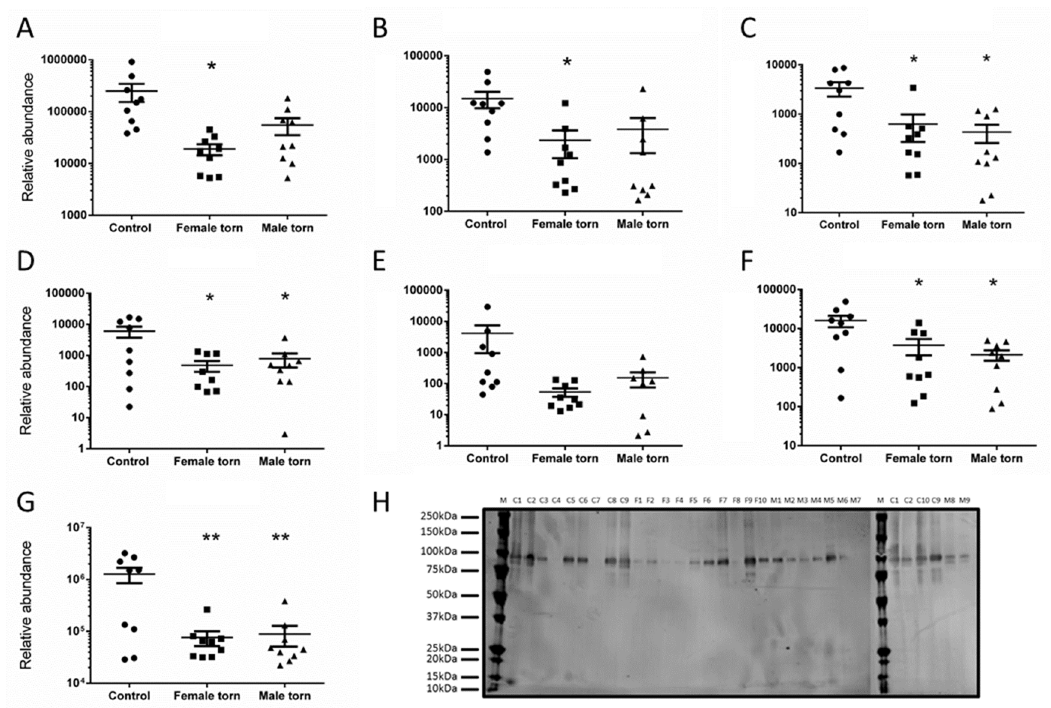
Fig 3. The relative abundance of differentially expressedelastic fibre components (A-D) and membersof the thrombospondin family associated proteins (E-G). Dot plots show biologicalreplicates, means and standarderror of the mean. (A) fibrillin-1(FBN1), (B) microfibrillar associatedprotein 5 (MFAP5), (C) Fibulin-1(FBLN1), (D) Latent- transforming growth factor beta-bindingprotein 2 (LTBP2), (E) Thrombospondin-1,(F) Thrombospondin4, and (G) cartilage oligomericprotein (COMP). (H) Western blot of COMP (around100kDa),confirminghigherprevalencein control comparedto female and male torn and aged tendon samples. * P < 0.05, ** P < 0.01significantly different from control.